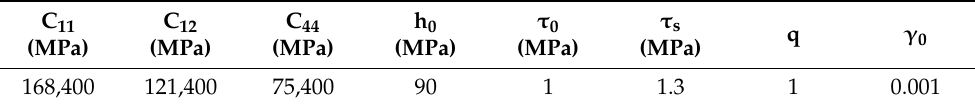
Table 5. Parameters in the constitutive model.